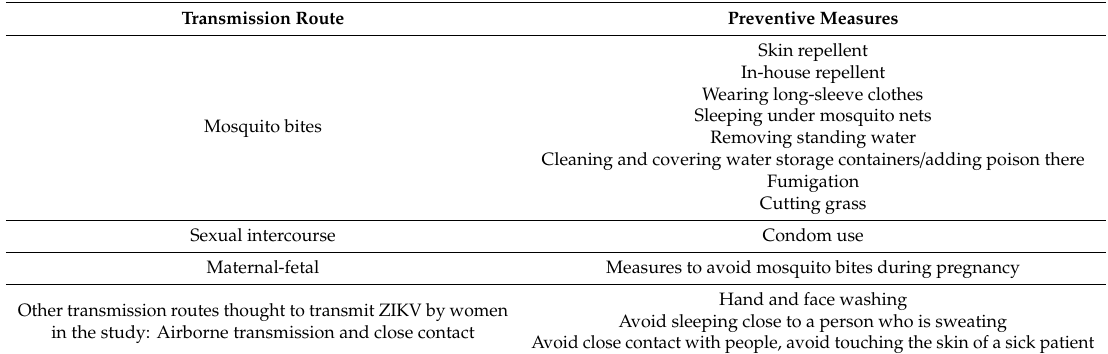
Table 2. ZIKV-prevention behaviors explored among